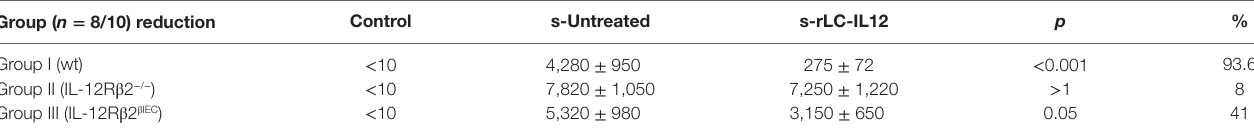
TaBle 1 | Effects of rLC-IL12 on IgE production (ng/ml): day 35. group ( n = 8/10) reduction control s-Untreated s-rlc-il12 p % Group I (wt) < 10 4,280 ± 950 275 ± 72 < 0.001 93.6 Group II (IL-12R β 2 − / − ) < 10 7,820 ± 1,050 7,250 ± 1,220 > 1 8 Group III (IL-12R β 2 β IEC ) < 10 5,320 ± 980 3,150 ± 650 0.05 41 Levels of plasma IgE were evaluated in wt (Group I) and chimeric mice deficient for IL-12R β 2 chain (Group II, IL-12R β 2 − / − ) or deficient for IL-12R β 2 chain in intestinal epithelial cells (Group III, IL-12R β 2 ∆ IEC ). Values refer to levels of IgE prior to the beginning of the sensitization period (control) and in mice sensitized and left untreated (s-untreated) or treated with rLC-IL12 (s-rLC-IL12) on day 35 following the final antigenic